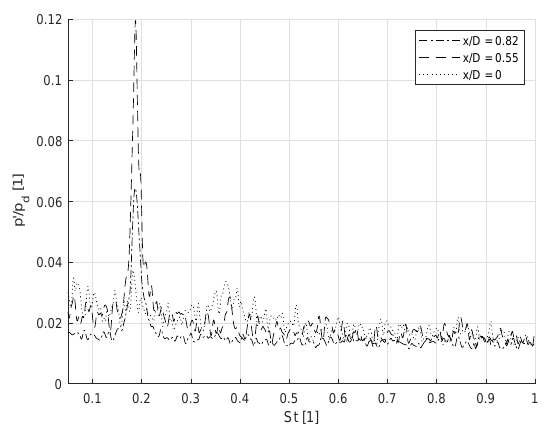
Fig. 6. The measured amplitude spectra normalized with dy- namic pressure for Re = 157 140 in the 3 di ff erent positions.